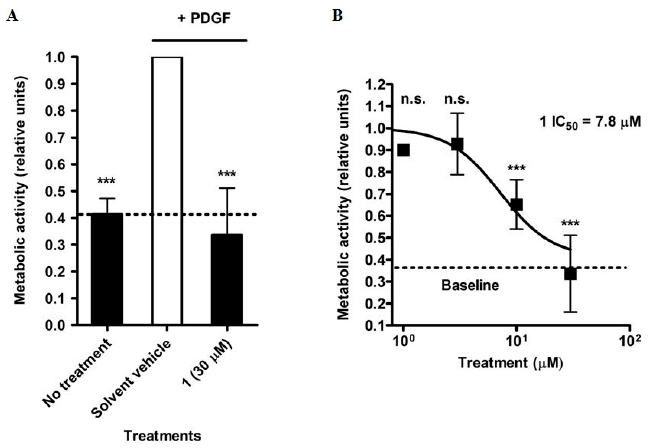
Figure 1. Inhibition of VSMC proliferation by gentisin ( 1 ), determined by the resazurin conversion method. Cells were treated with the indicated concentrations of 1 for 48 h. ( A ) represents the data obtained from VSMC treated or untreated with PDGF, as well as the inhibitory effect of 30 µM 1 on PDGF-induced VSMC proliferation; ( B ) depicts the results obtained from dose response studies (investigated concentrations: 1, 3, 10, and 30 µM) used to determine the IC 50 of 1 . Values are presented as means ± SD, relative to the PDGF stimulated solvent vehicle control (0.1% DMSO) ( n = 3). *** p < 0.001, n.s. not significant (ANOVA/Bonferroni).